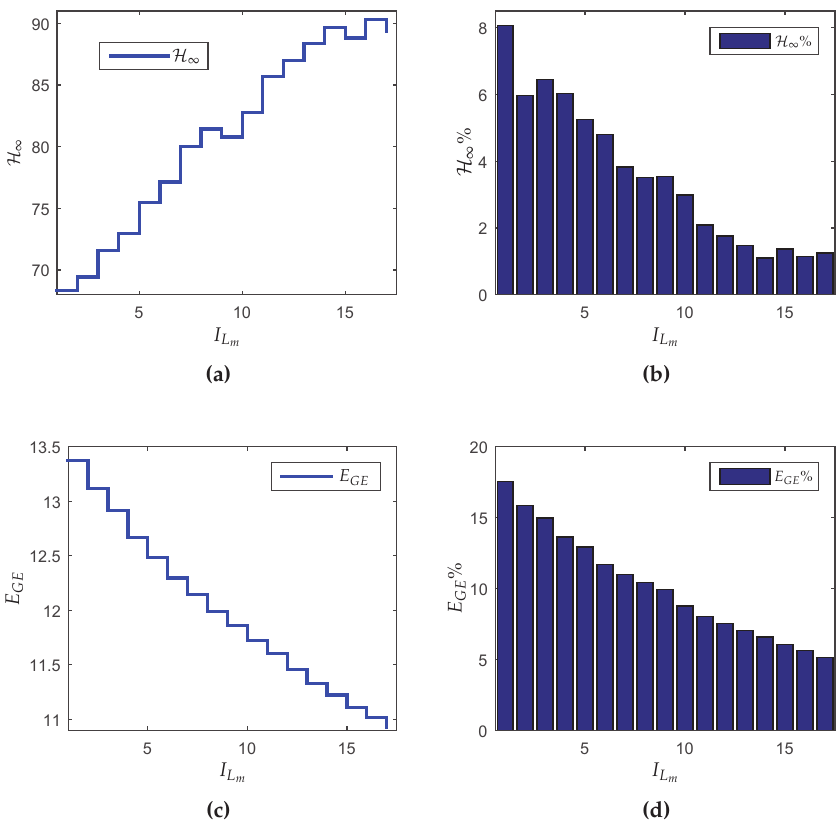
norm of the closed-loop system using the mixed approach; ( b ) Percentage difference Figure 8. ( a ) H ∞ between the norm obtained by the second and third energy saving protocols; ( c ) The global energy consumption ( E GE ) of the network using the mixed approach; ( d ) Percentage difference between the global energy consumptions obtained by the second and third energy saving protocols. All the parameters are evaluated in terms of the distinct network settings organized according to the sequence I Lm